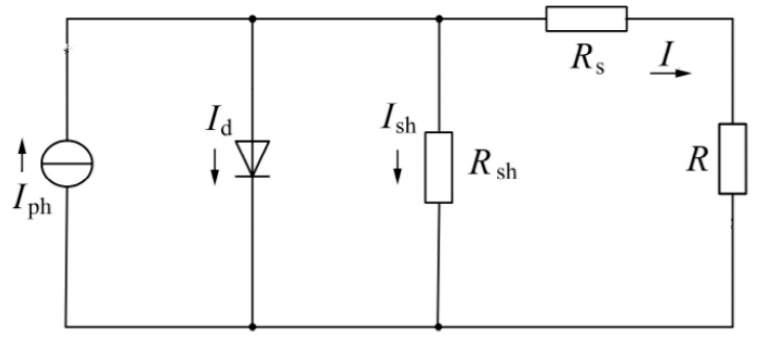
Figure 8. Equivalent circuit diagram of photovoltaic cell.